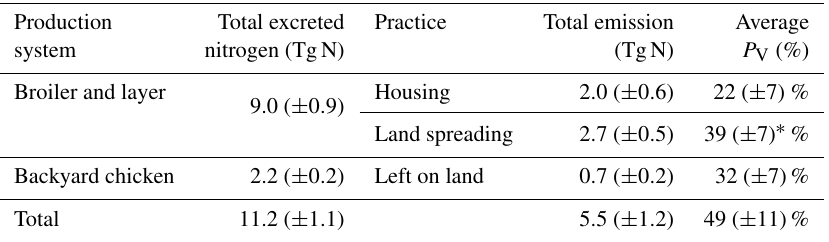
Table 1. Excreted nitrogen from housed and backyard chickens, and estimated annual NH 3 emissions from each practice based on 2010 values.